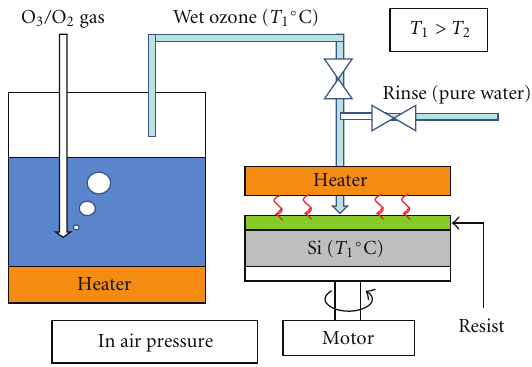
Figure 1: Experiment apparatus for resist removal using wet ozone. Table 1: Film thickness, polymers, and solvents. Polymer samples/solvents AZ6112 1.35 Novolak resin ( M w = 15000)/PGMEA 0.96 cis-1,4-polyisoprene ( M w =